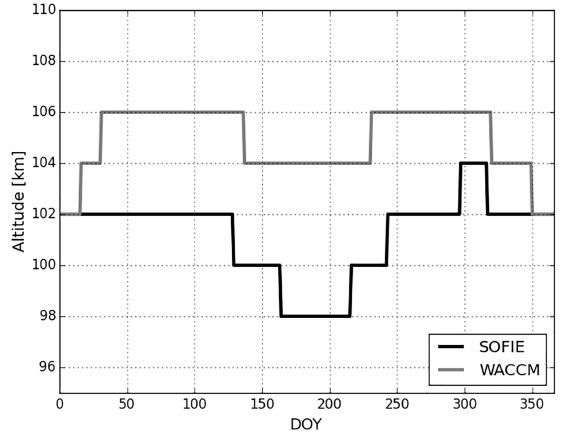
Figure 3. Altitude of the maximum NO number density obtained from the SOFIE and WACCM seasonal climatologies in Fig. 1.